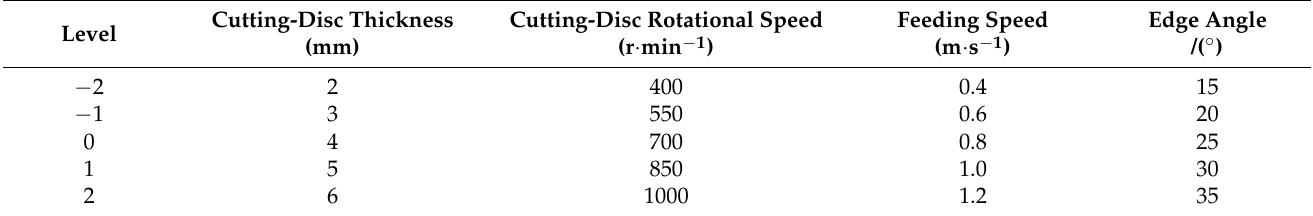
Table 2. Test factors and